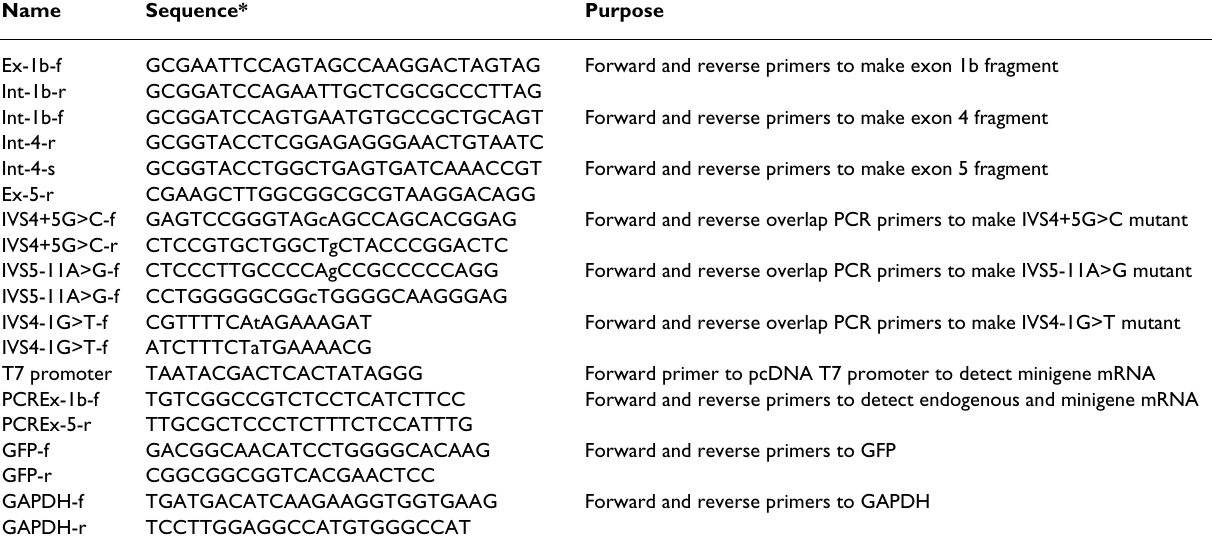
Table 1: Oligonucleotides used in this